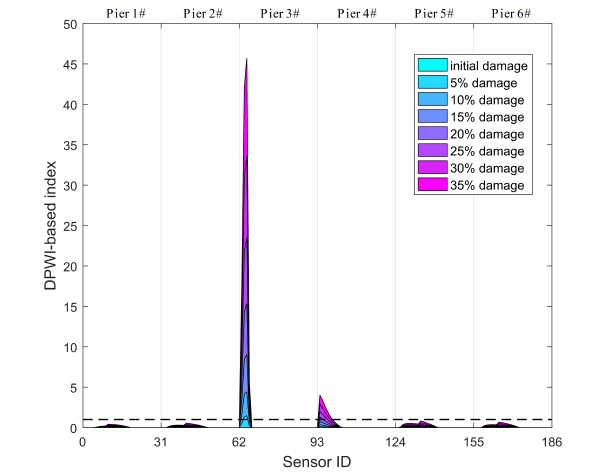
Figure 12. Identification results of Damage I for all six piers using warning values.